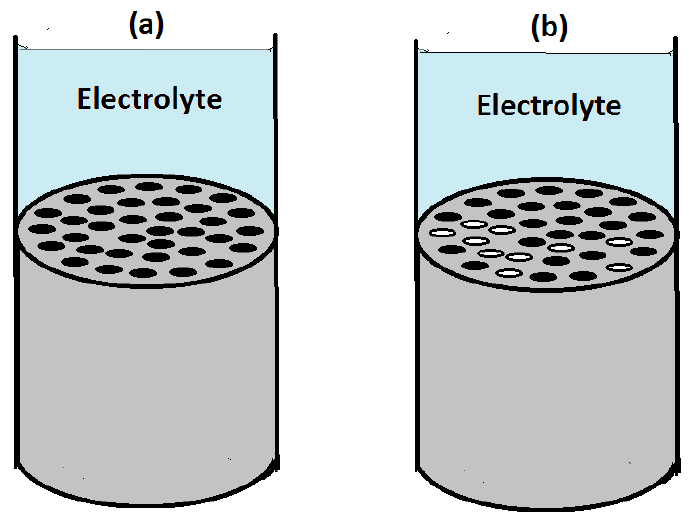
Figure 7. Schematic illustration of the change in the electrochemically active surface area that can result from reduction of the effective carbon fiber surface area either by surface modification or by a loss of electrical continuity in damaged carbon fibers, ( a ) Intact CFRP sample ( b ) CFRP sample with electrochemically active surface area diminished either by surface modification or breakage of carbon fibers (In black are the carbon fibers, white are damaged/surface modified fibers, and in grey is the matrix).